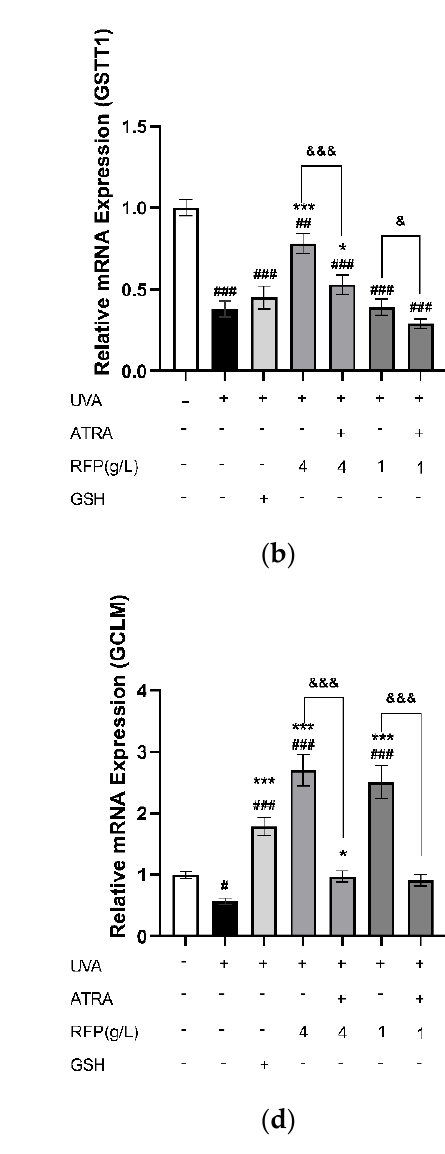
Figure 7. Effects of RFP on relative expression of GST and GCL genes: ( a ) effect on GSTM1; ( b ) effect on GSTT1; ( c ) effect on GCLC; and ( d ) effect on GCLM. # p < 0.033, ## p < 0.002, ### p < 0.001 as compared to control group; * p < 0.033, ** p < 0.002, *** p < 0.001 as compared to damage model group; & p < 0.033, &&& p < 0.001 as compared to the group with ATRA. Values do not have a common mark (#, *, &) when p > 0.033.